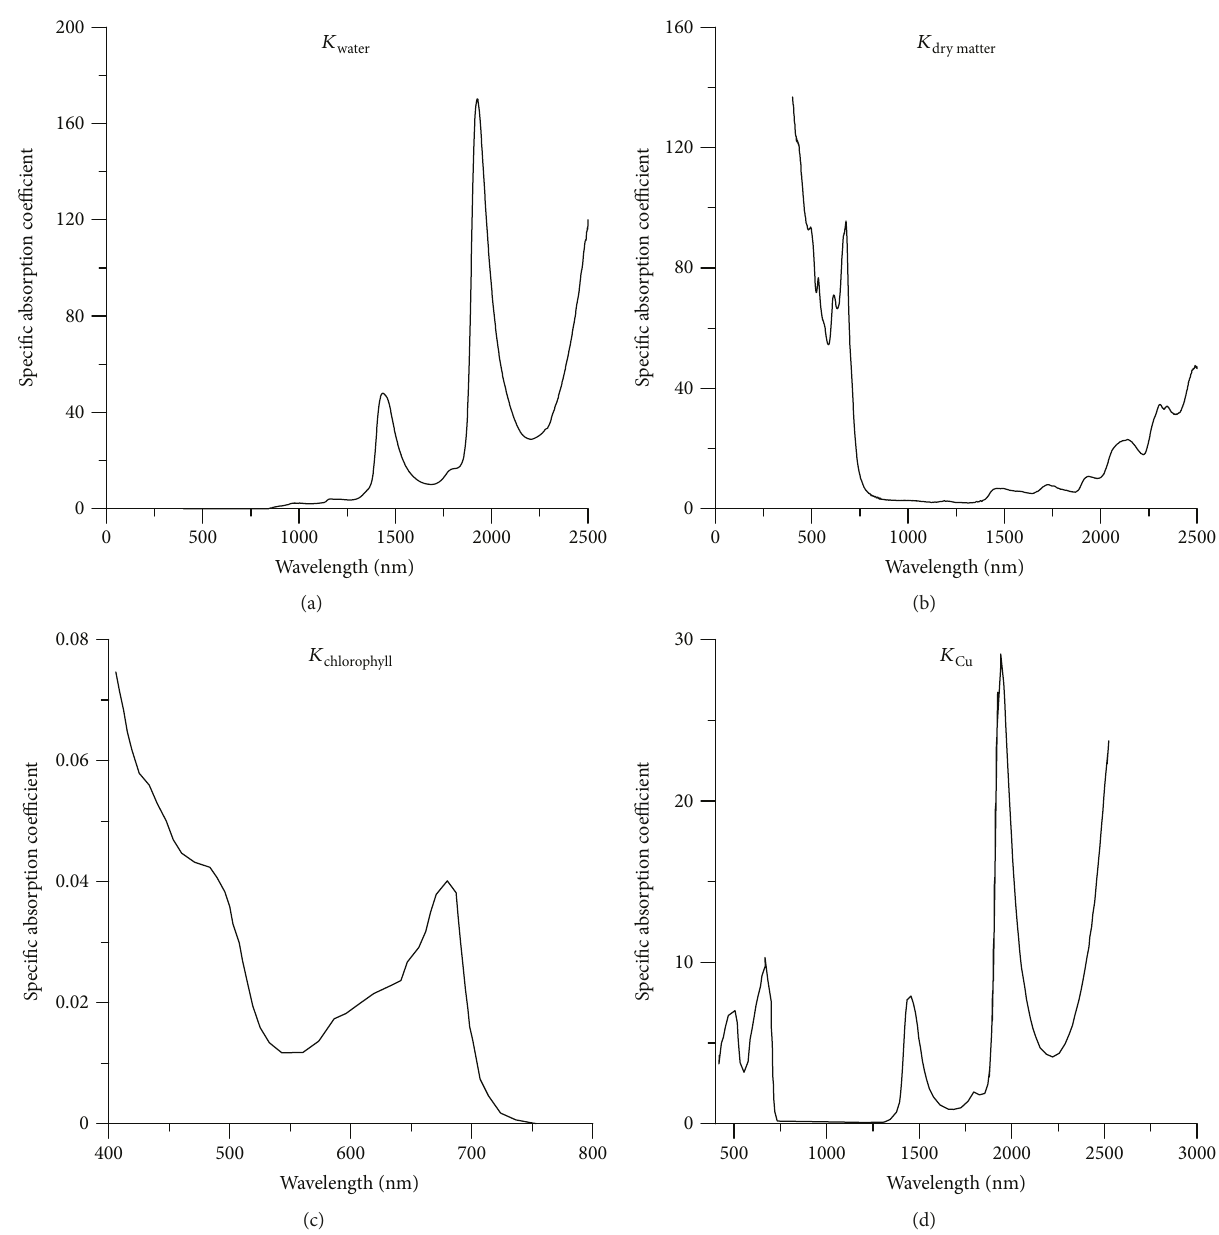
Figure 4: Speci fi c absorption coe ffi cients of water (a), dry matter (b), chlorophyll (c), and copper ion (d). The wavelength of chlorophyll is plotted in the range of 400 – 800 nm for, at the other wavelength, the speci fi c absorption of chlorophyll is